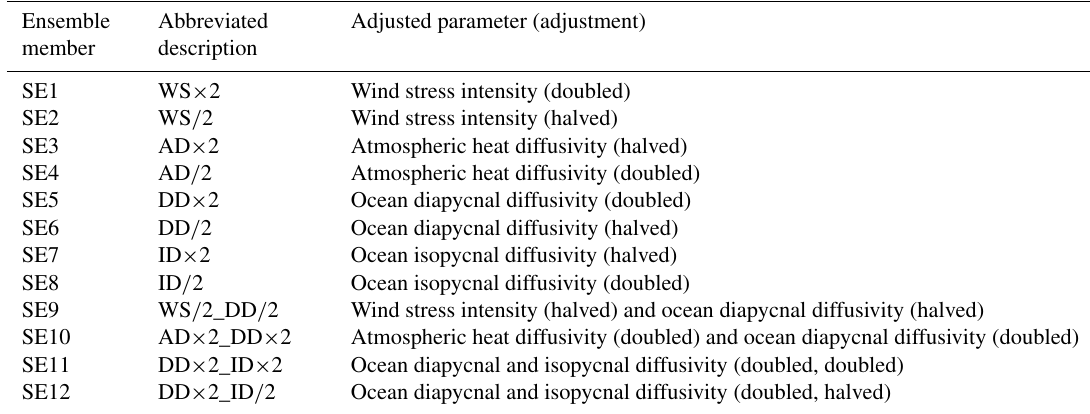
Table 1. List of sensitivity experiment equilibrium states SE1–SE12, abbreviated ensemble member description and specification of which one or two physical characteristics have been altered compared to the control PIES278. The nature of the change is specified in parenthesis. Ensemble Abbreviated Adjusted parameter member description